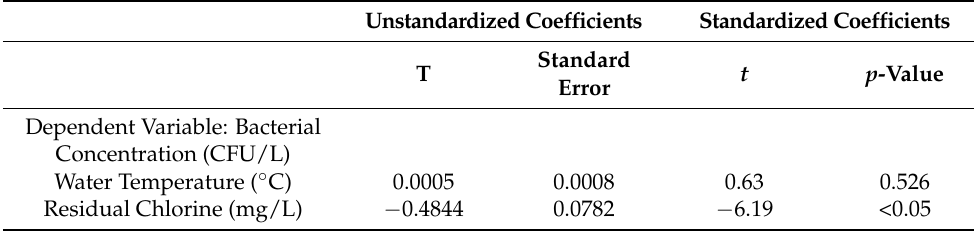
Table 5. Results of linear multiple regression.